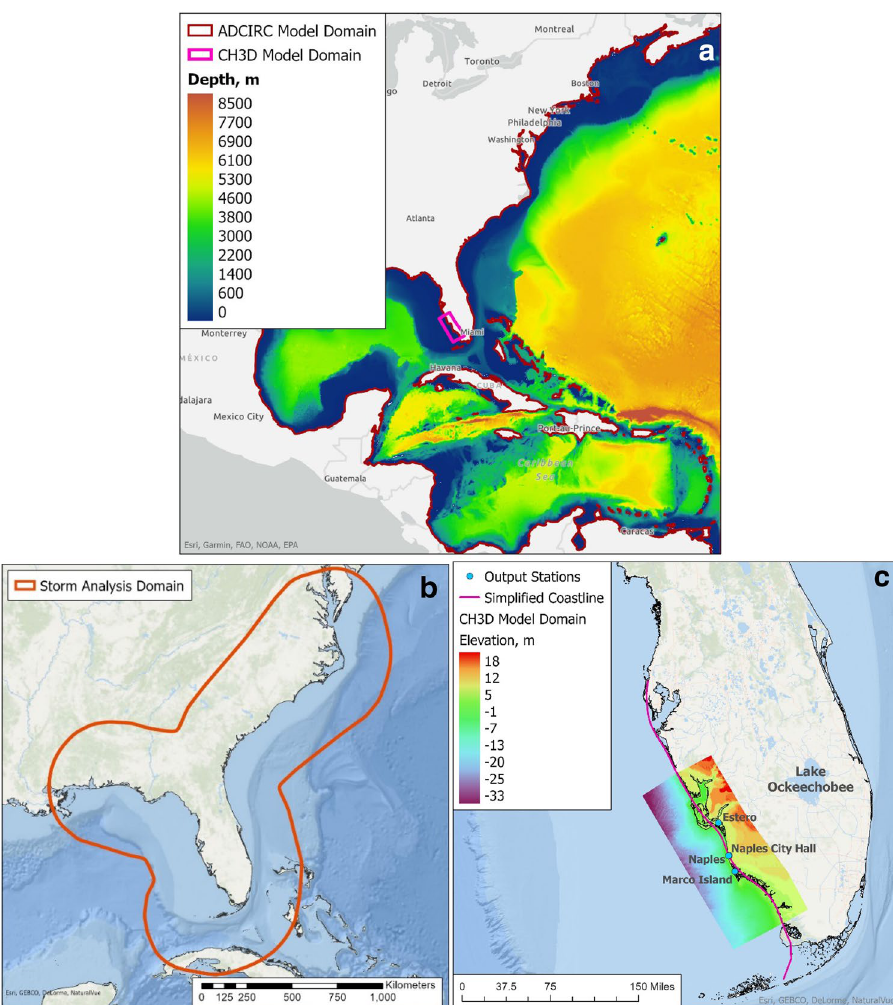
Figure 1. ( a ) SWFL model domain inside the large ADCIRC or CH3D domain; ( b ) Southeastern US domain used by Liu et al. (2014) for TC downscaling analysis with 12-km WRF; ( c ) SWFL model domain with idealized coastline for JPM and CH3D-SWAN model output stations. Elevations are shown with respect to NAVD88. Gentle bathymetric and topographic slope (~ 1/1000) is much lower than that in Southeast Florida. The simplified coastline is 425 km long, constituting 20% of Florida’s coastline and exceeding the combined coastlines of NJ and